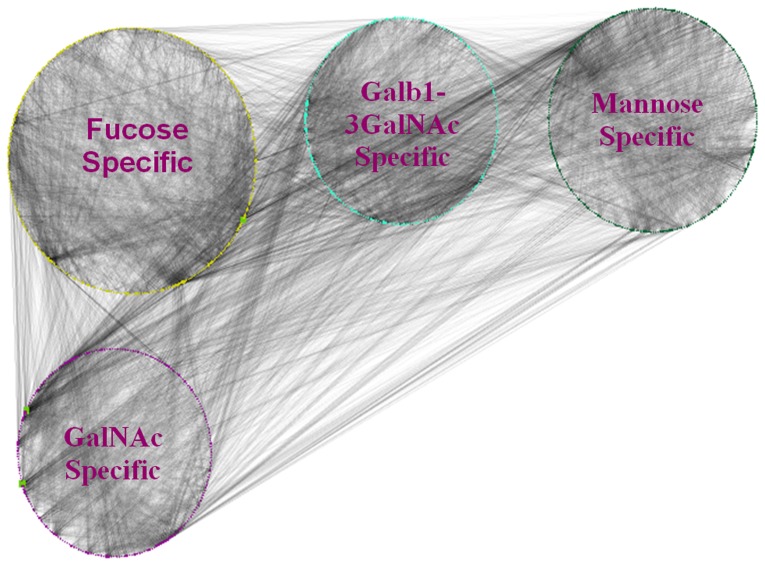
Graphical representation of four communities identified by Mod-CSA is shown.The figure provides an overall picture of the whole network with four main functional categories based on the p-value analysis.